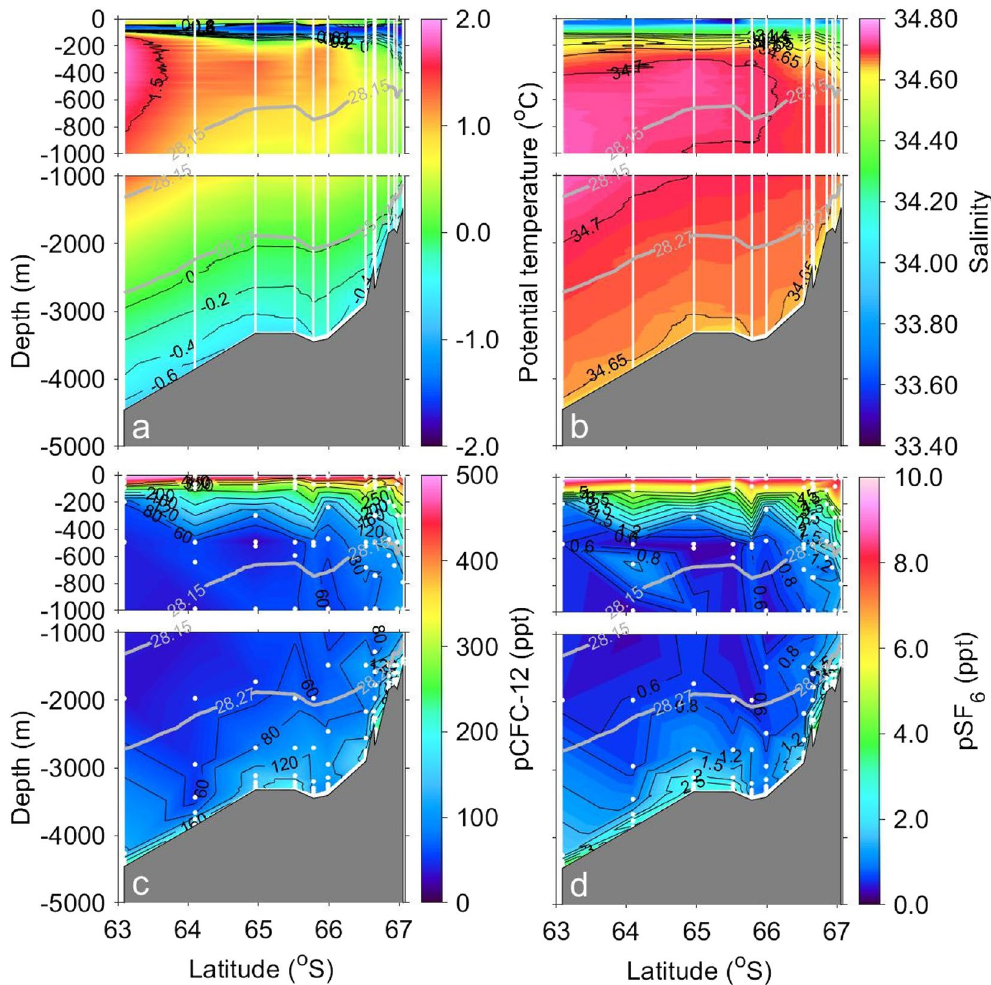
Figure 2. Contour plots of ( a ) potential temperature, ( b ) salinity, ( c ) pCFC-12, and ( d ) pSF 6 along Wild Canyon (white line in Fig. 1). Data were obtained during cruises of KH19-01 and KH20-01. Gray horizontal lines indicate neutral densities of 28.15 kg m −3 and 28.27 kg m −3 . The figure was generated using